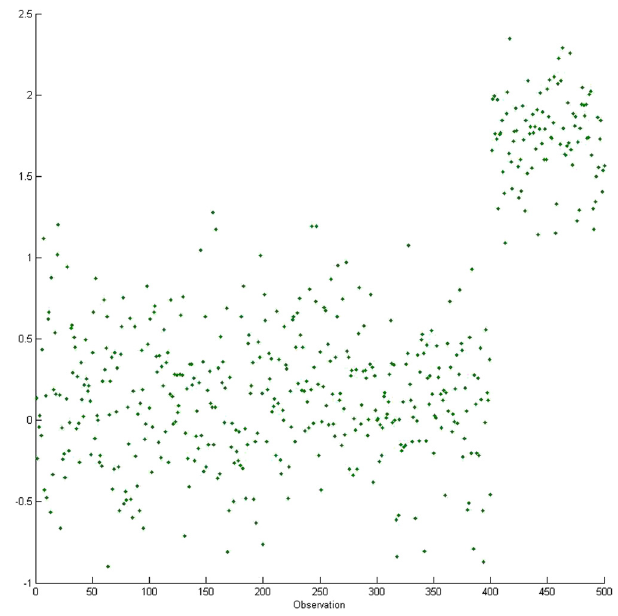
Figure 1: Spread observation example of a group of